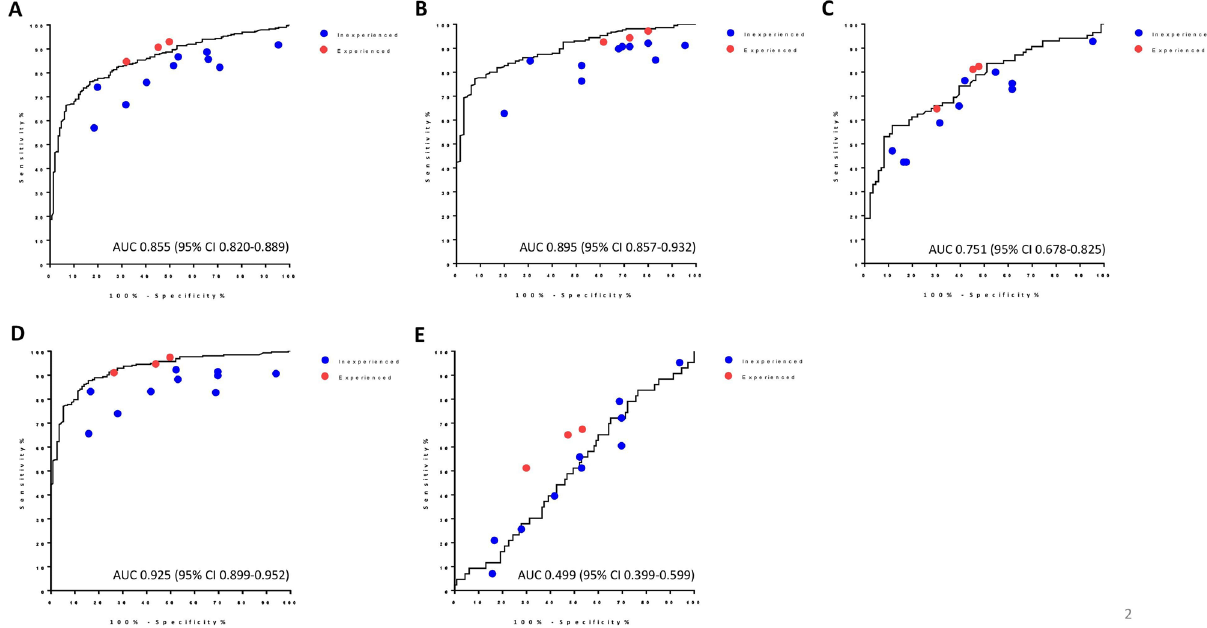
Figure 1. Comparison of diagnostic performance between CAD and physicians with different levels of experience. The ROC curves and AUC of CAD in the diagnosis of thyroid nodules are demonstrated in black solid lines in each graph for ( A ) all nodules, ( B ) nodules with a size < 2 cm, ( C ) nodules with a size ≥ 2 cm, ( D ) nodules diagnosed as cPTC, and ( E ) nodules diagnosed as FTC and fvPTC. Dots on each graph indicate the diagnostic performance (sensitivity and specificity) of the individual physicians in inexperienced (blue), and experienced (red) groups. CAD, computer-aided diagnosis; ROC, receiver operating characteristic curve; AUC, area under the curve; cPTC, conventional papillary thyroid carcinoma; FTC, follicular thyroid carcinoma; fvPTC, follicular variant papillary thyroid